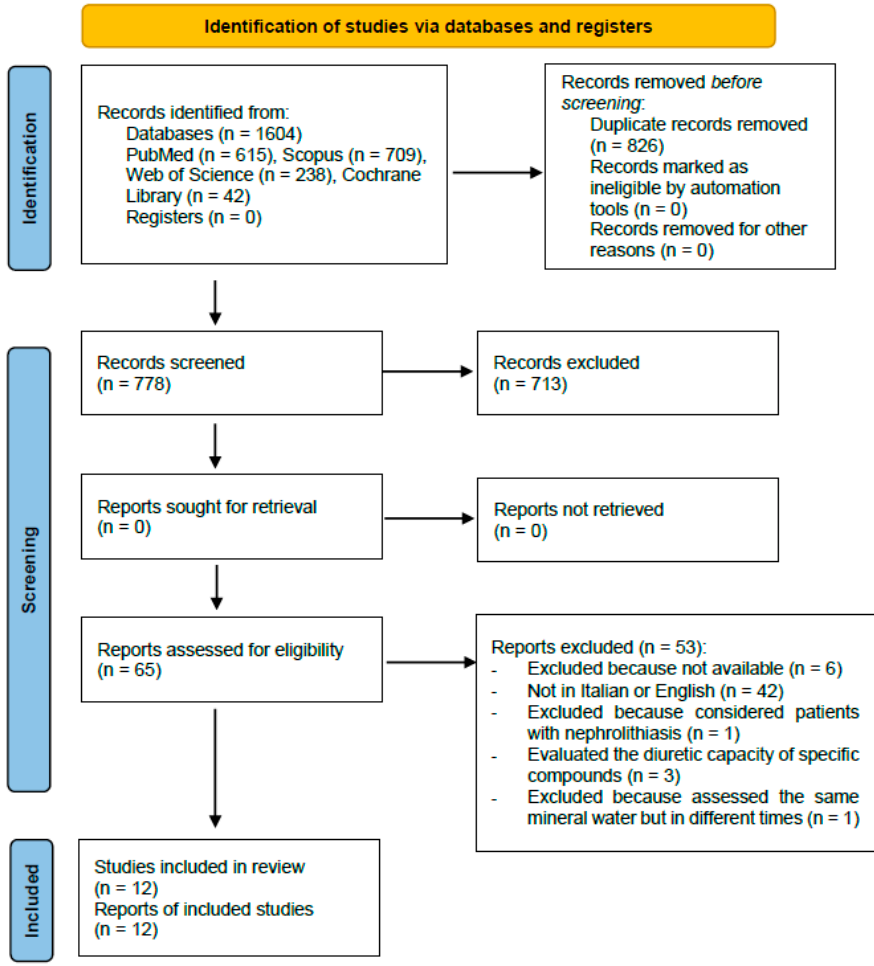
Figure 1. Selection studies fl owchart.